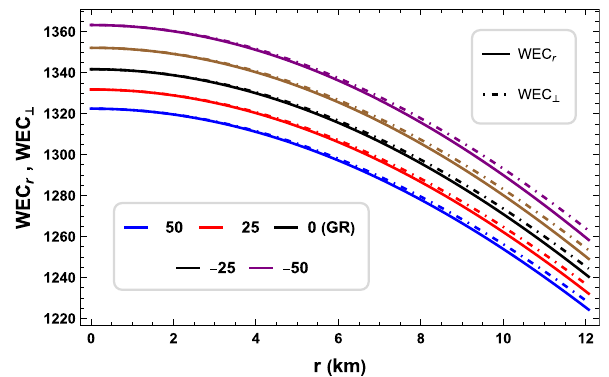
Fig. 13 WEC against radial distance r in PSR J0348+0432 for differ- ent α values in 5D